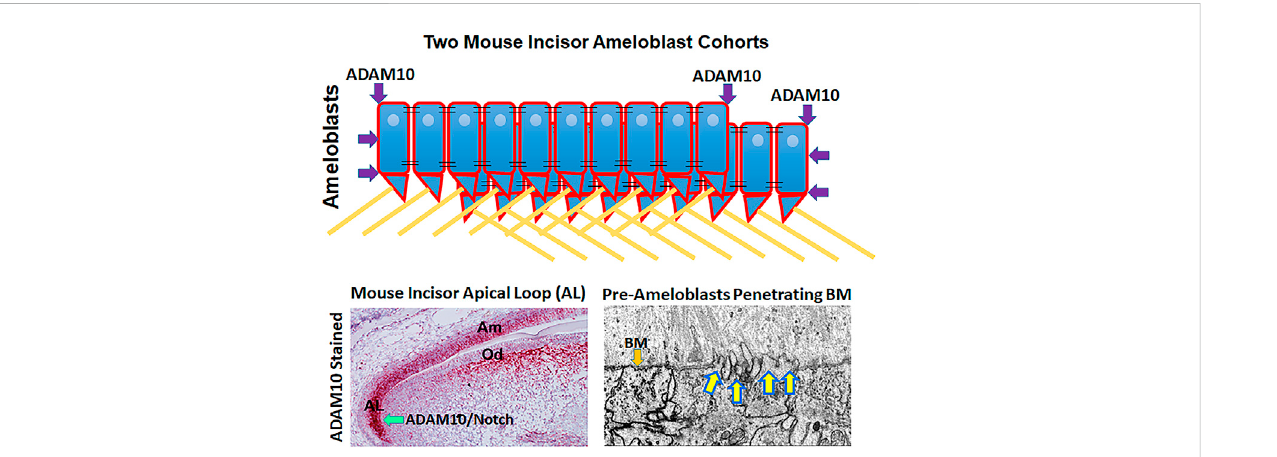
FIGURE 1 Possible mechanisms by which ADAM10 may facilitate enamel development. (Top) Schematic showing how ADAM10 may cleave the ends of ameloblastcohortssothattheycanslidebyoneanotherduringthesecretorystageofenameldevelopment.Thecell-cellconnectionswouldalsobe removed between the sliding cells (not shown). Black parallel lines, tight junctions; right triangles, Tomes ’ processes; yellow lines, enamel rods (interrods not shown). (Bottom Left) Mouse incisor section stained red by in situ hybridization for ADAM10 (Ikeda et al., 2019). Adam10 expression begins in the apical loop and continues until the ameloblasts reach the transition stage of enamel development. Adam10 may facilitate Notch signaling to maintain the stem cell niche within the apical loop (Felszeghy et al., 2010). (Bottom Right) Focused Ion Beam Scanning Electron Microscopy (FIB-SEM) demonstrating that pre-ameloblasts extent fi nger-like projections to penetrate the basement membrane (BM) that separates thepre-ameloblastssfromthepredentinorganicmatrix(Bartlettetal.,2021).SinceADAM10isexpressedduringthistime,itispossiblethatitassistsin penetrating the basement